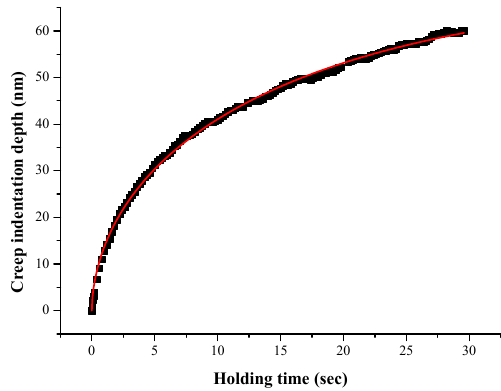
Figure 2. Power law fitting on actual creep depth versus time curve.